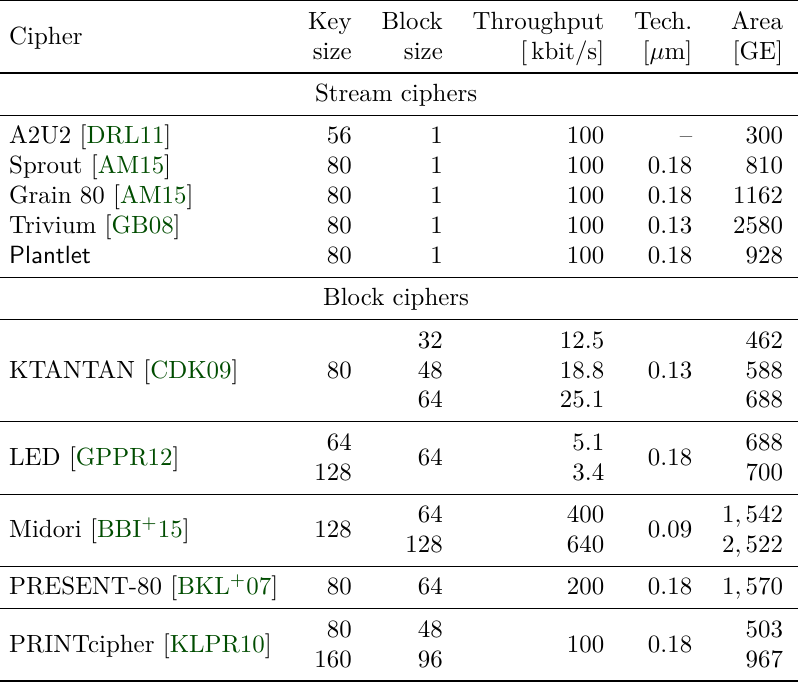
Table 6: Overview of different lightweight ciphers regarding key and block size, throughput at 100 kHz, the logic process (denoted Tech.), and the required area size. The figures are given for the case, when the key is stored in non-rewritable memory (e.g. MROM or PROM). Note that for A2U2, no logic process information is given and the area size is an estimate as reported in [DRL11]. As there were no throughput figures given for Midori in [BBI + 15], we computed them based on the number of rounds and the block size as described for the original